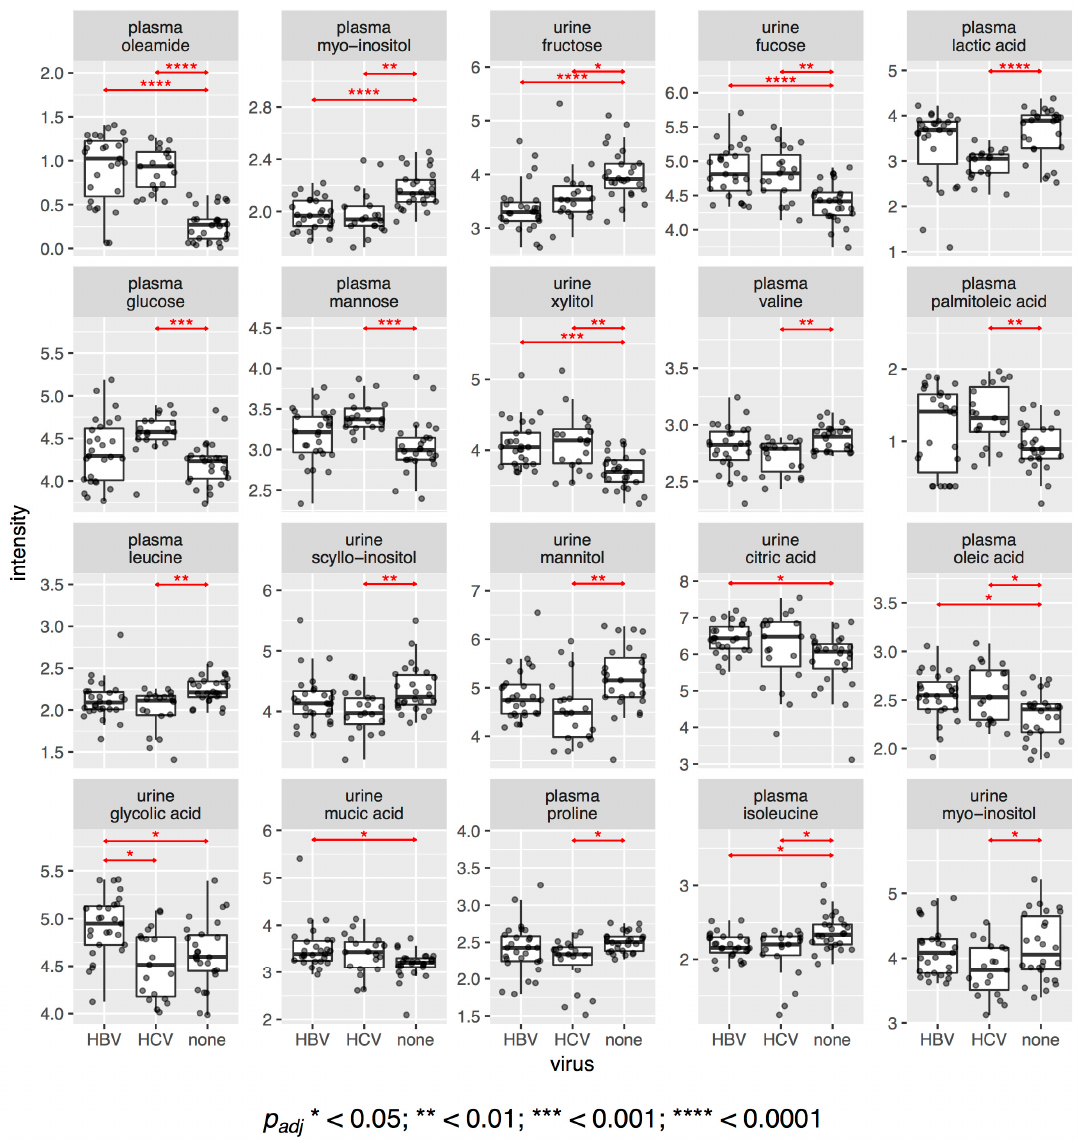
Figure 2. Dot and boxplots for the metabolites with statistically significantly different intensities between the three sub-cohorts. The p values are adjusted for multiple comparisons (Benjamini-Hochberg).